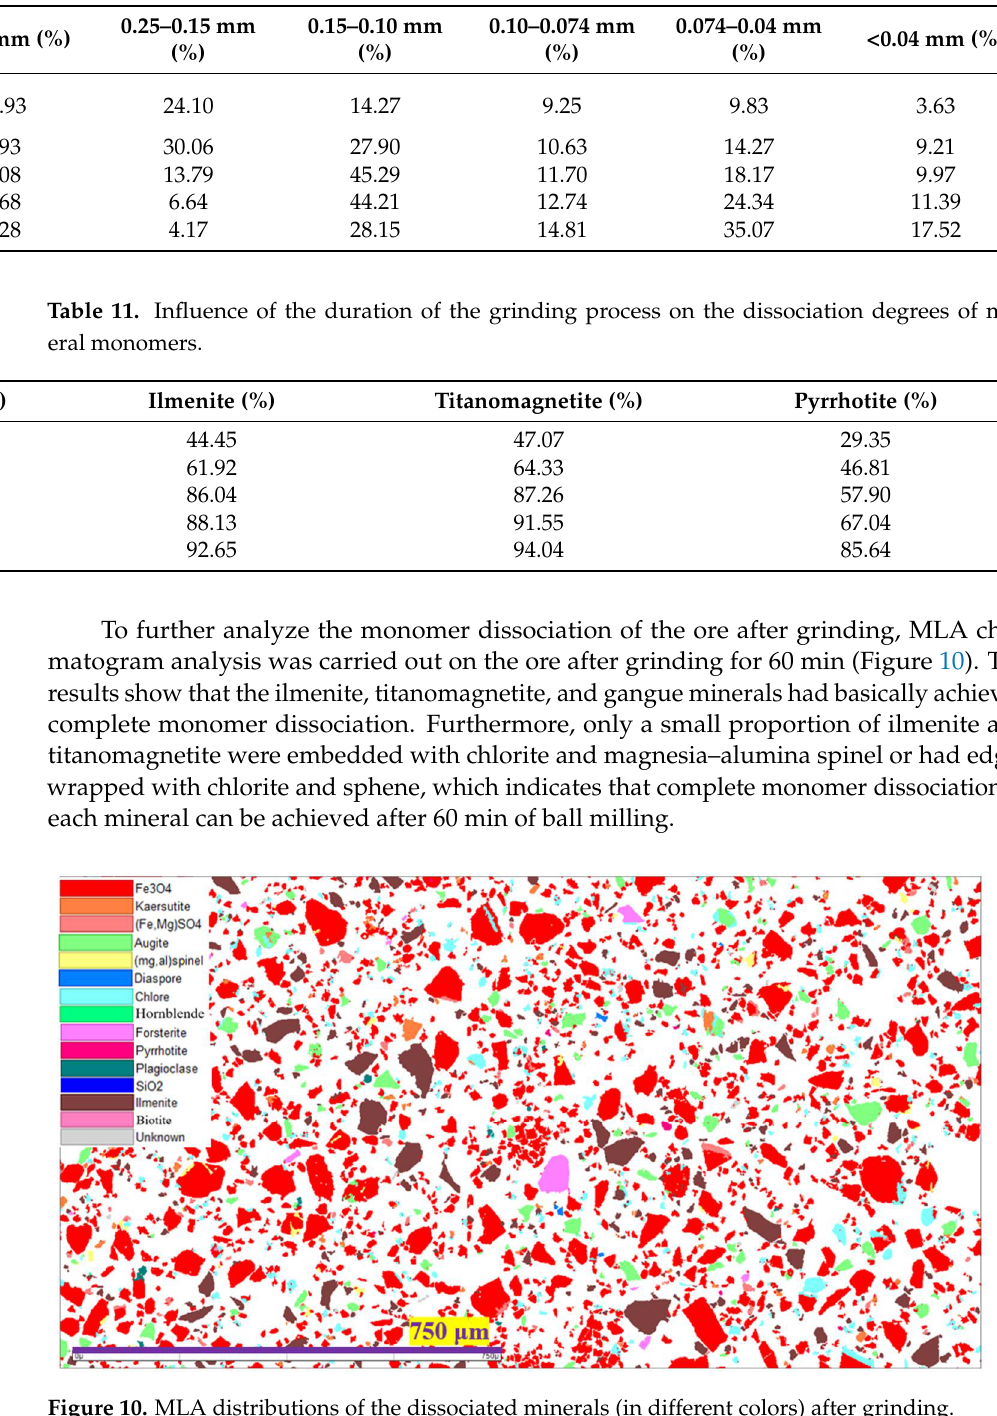
Table 10. Influence of the duration of the grinding process on the particle size distribution of the ore.